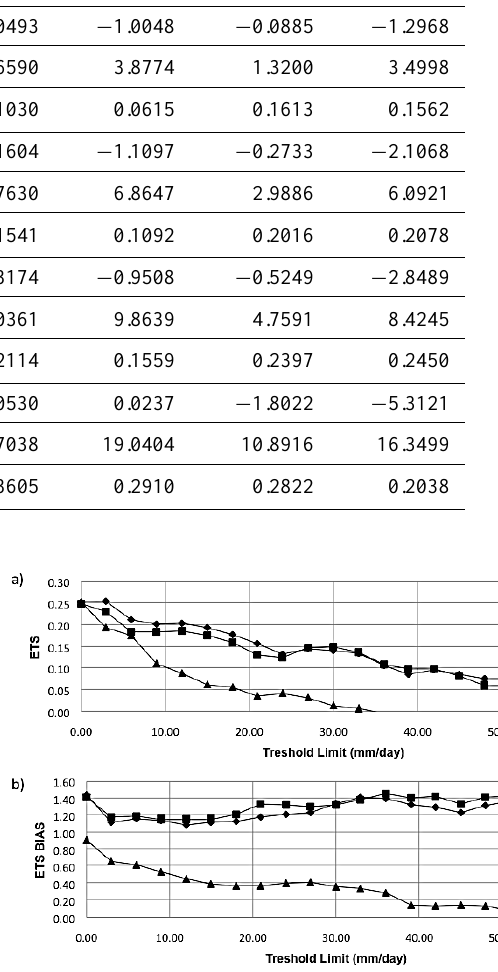
Table 4. Bias and RMSE in [mm] and correlation coefficient ( R ) of WRF AS, WRF NOAS, and MPE for regular and conditional rain amounts at 1, 3, 6 and 24h intervals are given. Conditional rain represents only non-zero observed precipitation cases. Obs.